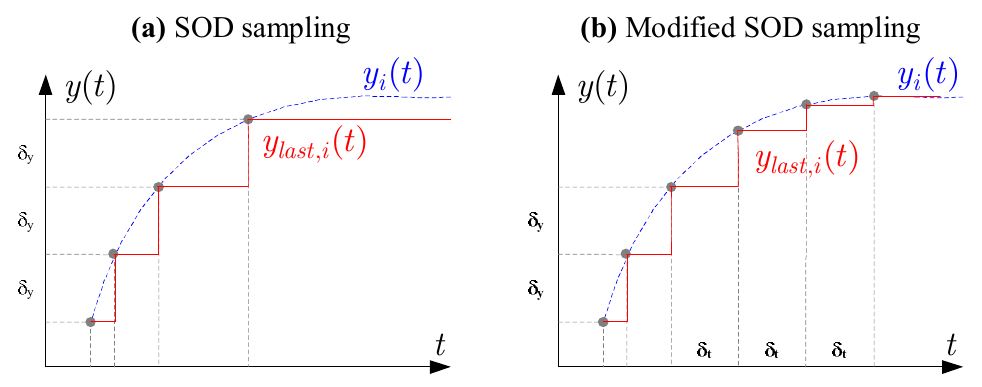
Figure 1. Principle of SOD and modified SOD sampling